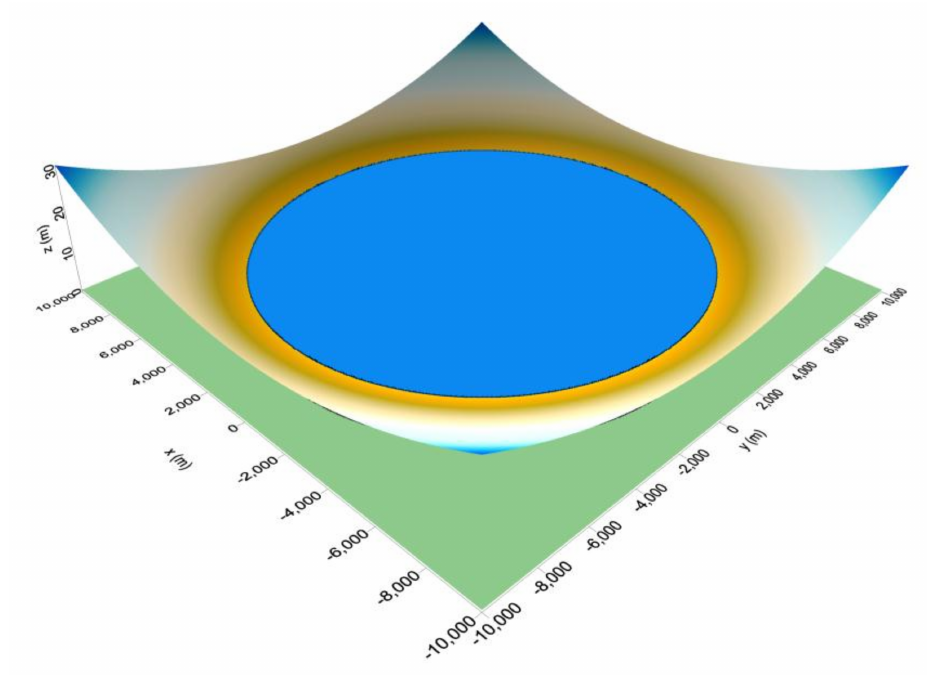
Figure 10. Sketch of water sloshing in a parabolic